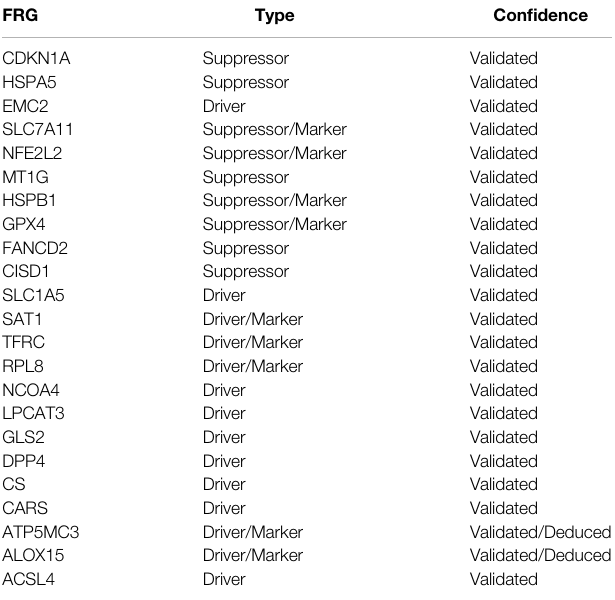
TABLE 1 | Annotation of 23 FRGs in the FerrDb